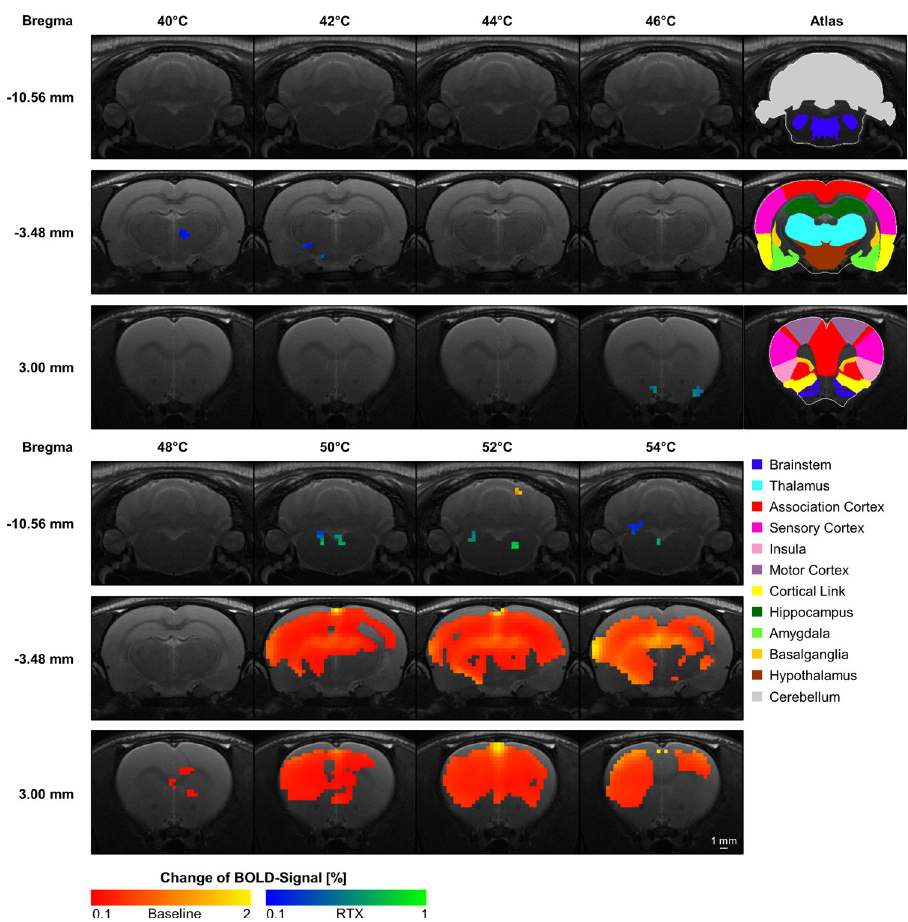
Fig 3. Significant differences in the whole brain maximal BOLD response amplitude evoked by different temperatures before and after RTX-treatment. The voxels in red-yellow showed greater activation at baseline, whereas the blue-green voxels showed greater activation after RTX treatment. Only very small differences (raw data showed comparable activation for both groups, data not shown) could be shown for temperatures � 48˚C, indicating that processing of innocuous temperatures remained unaffected by RTX and the resulting desensitization of TRPV1-expressing neurons. However, baseline showed significantly higher activation for noxious temperature above 48˚C in wide areas of the brain (subcortical and cortical). Data are represented as percentage change of maximal BOLD response amplitude. Only voxels with p-values � 0.05 (FWE permutation corrected) are shown. (n Baseline = 18; n RTX =